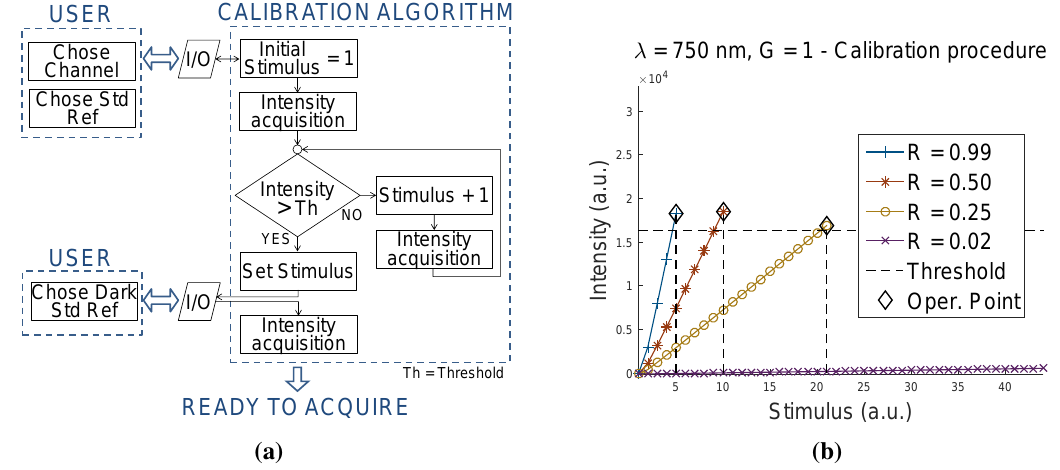
Figure 4. ( a ) Block diagram for the calibration procedure along a generic channel; ( b )